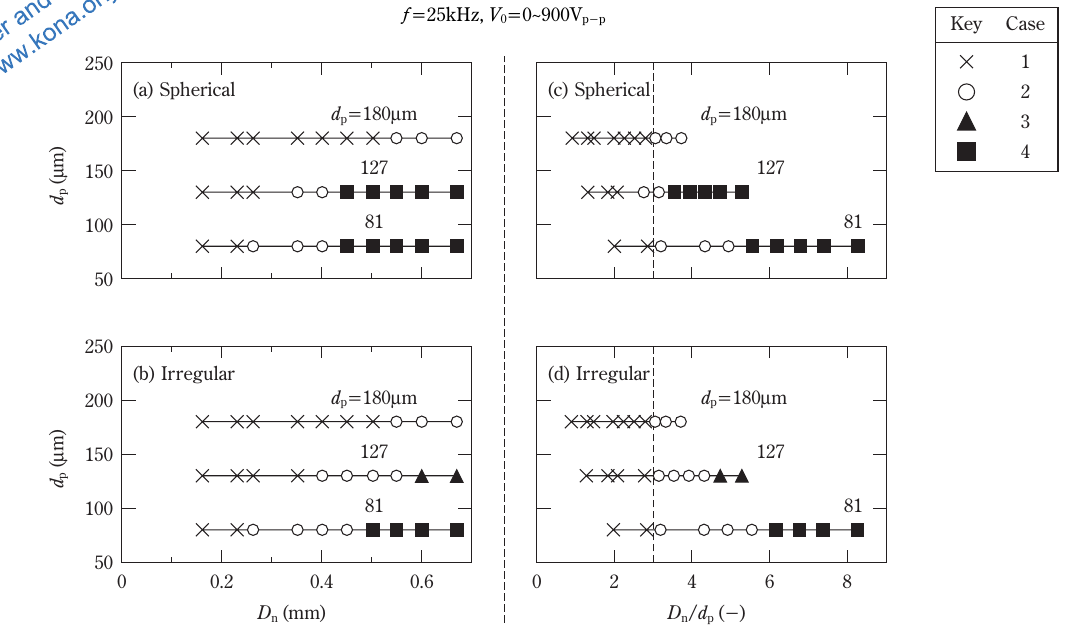
Fig. 3 Particle discharge characteristics (Case-1 to Case-4) obtained for particle diameter d p and nozzle inside diameter D n